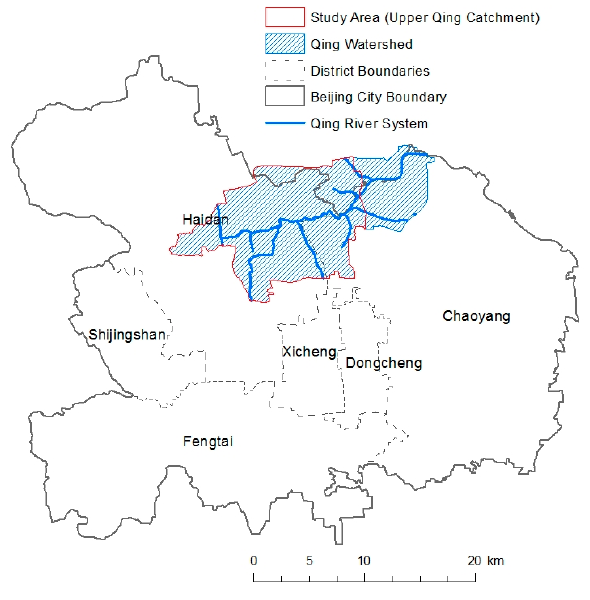
Figure 2. Location of Upper Qing Catchment study area in Beijing, China.